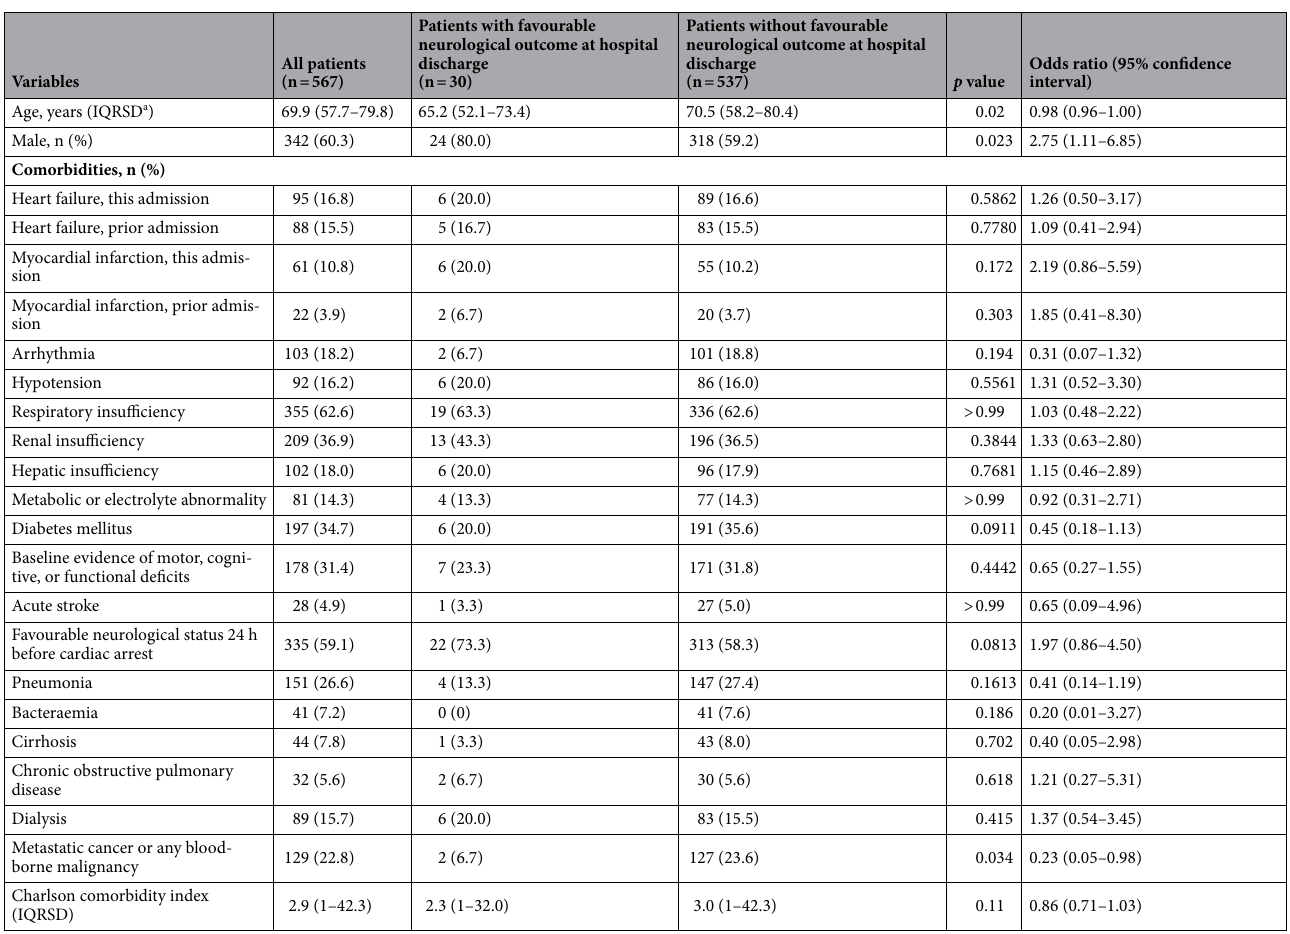
Table 1. Baseline characteristics of study patients. a IQRSD, interquartile rangesstandard